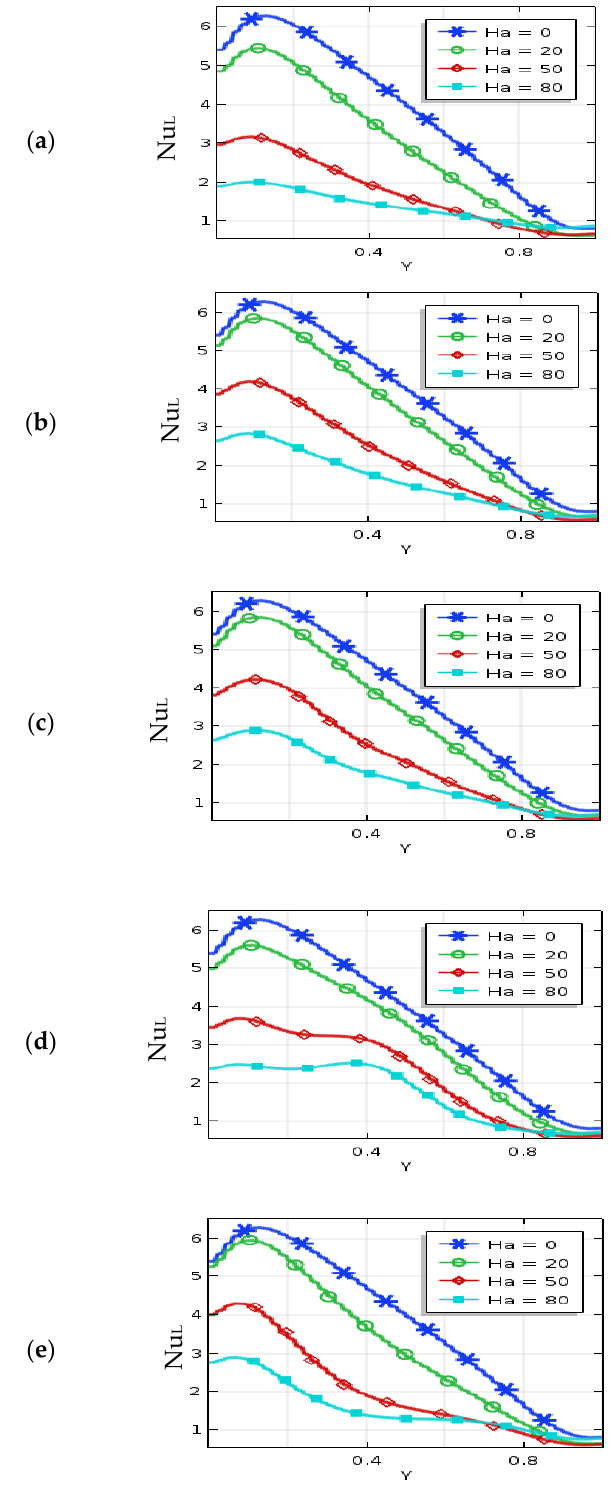
Figure 7. Local Nusselt number for Hartmann number ( Ha ) and ( a ) umf, ( b ) λ = 0.1, ( c ) λ = 0.25, ( d ) λ = 0.5, and ( e ) λ = 1 when Ra = 10 6 , φ = 0.04, d = 10 nm, n = 3, and τ = 1.